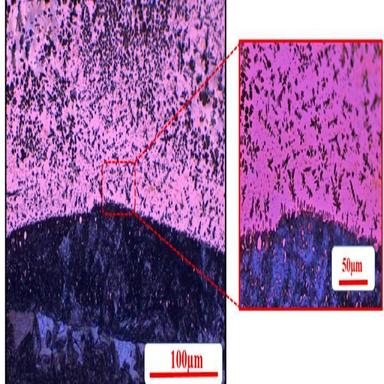
Typical Microstructure of LDED deposited Cu track.